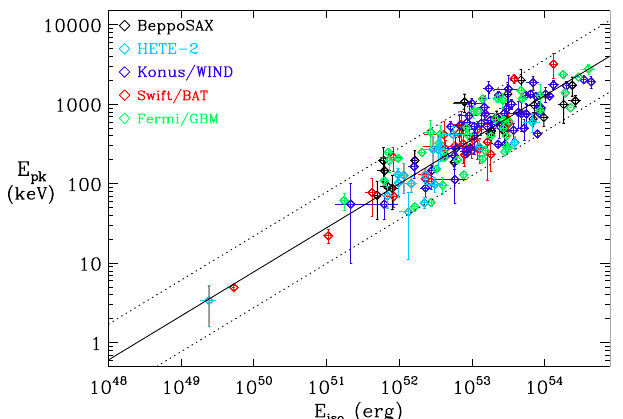
Figure 3. The E pk - E iso diagram of LGRBs taken from Amati and Della Valle [109] (Credit: Measuring Cosmological Parameters with Gamma Ray Bursts, Amati and Della Valle, International Journal of Modern Physics D, 22, 14, ©2013 World Scientific). The solid and dashed lines show the best fit function and the 2 σ systematic errors of the Amati relation,